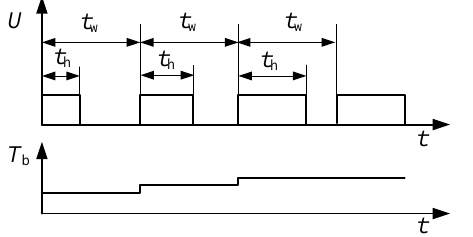
Figure 3. Relationship between the mean brake torque and the duty cycle.